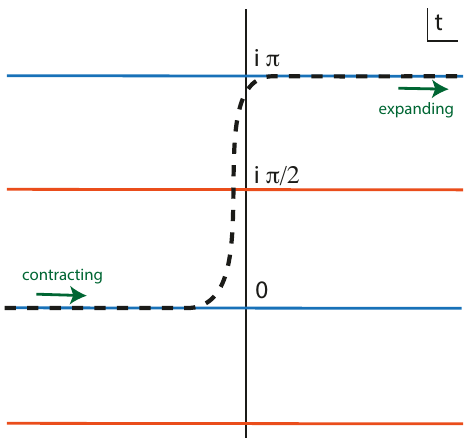
Figure 10 . Lines of real (in blue) and pure imaginary (in orange) scale factor values in the complexified time plane, for a ( t ) = cosh( t ) . In this figure, real Lorentzian time is horizontal and Euclidean time vertical. One can model a quantum bounce (dashed black line) by linking a contracting universe to an expanding one at a different, parallel line of real field values, but such a path necessarily passes through a line on which the scale factor is imaginary (orange